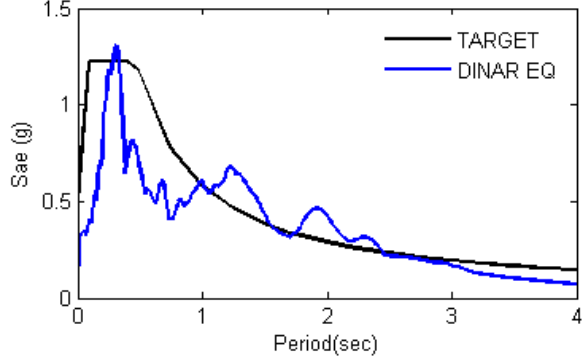
Figure 6. Comparison of target response spectrum created for ground motion level 2 and response spectrum of Dinar, Turkey 1995 earthquake.